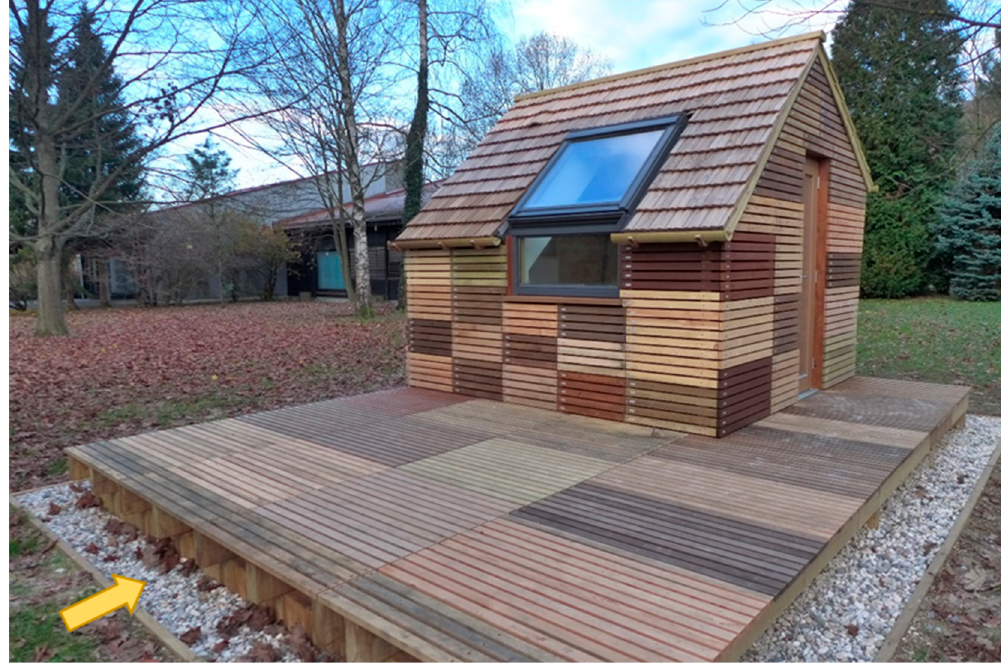
Figure 1. Wooden model house unit in October 2013 at the beginning of the exposure. Yellow arrow is pointing north.